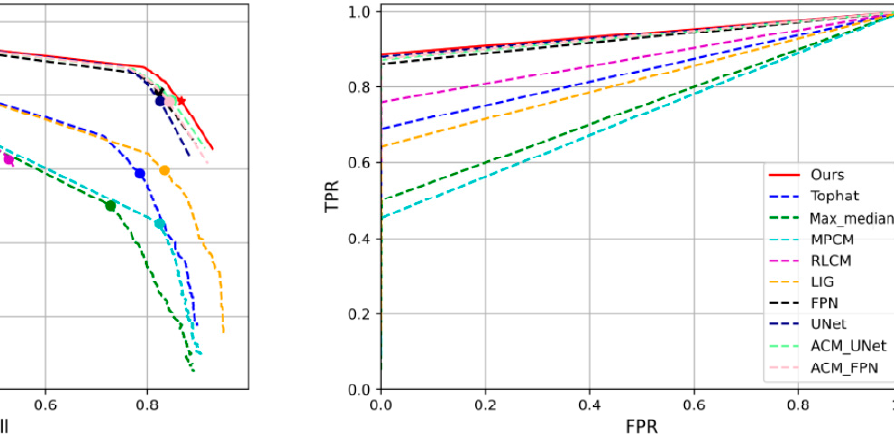
(a) Average precision comparison with other state-of-the-art methods .